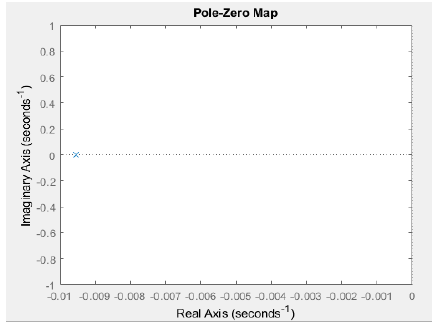
Figure 7. Diagram of poles and zeros weaving process.